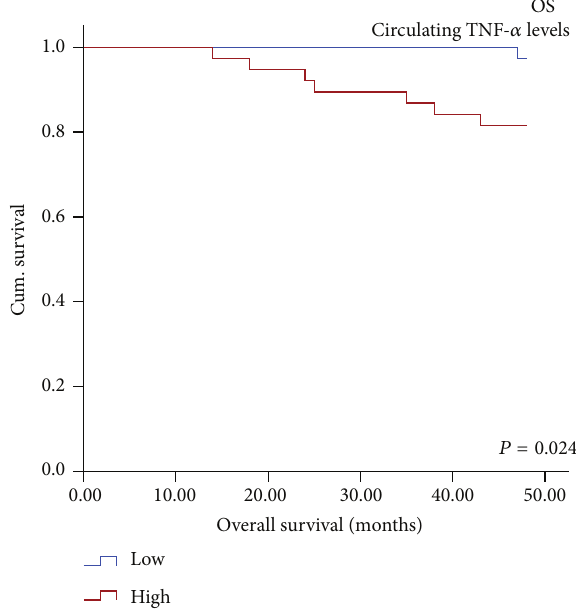
Figure 6: Significantly reduced OS observed in PTC patients with high levels of serum TNF- 𝛼 as compared to its counterpart.